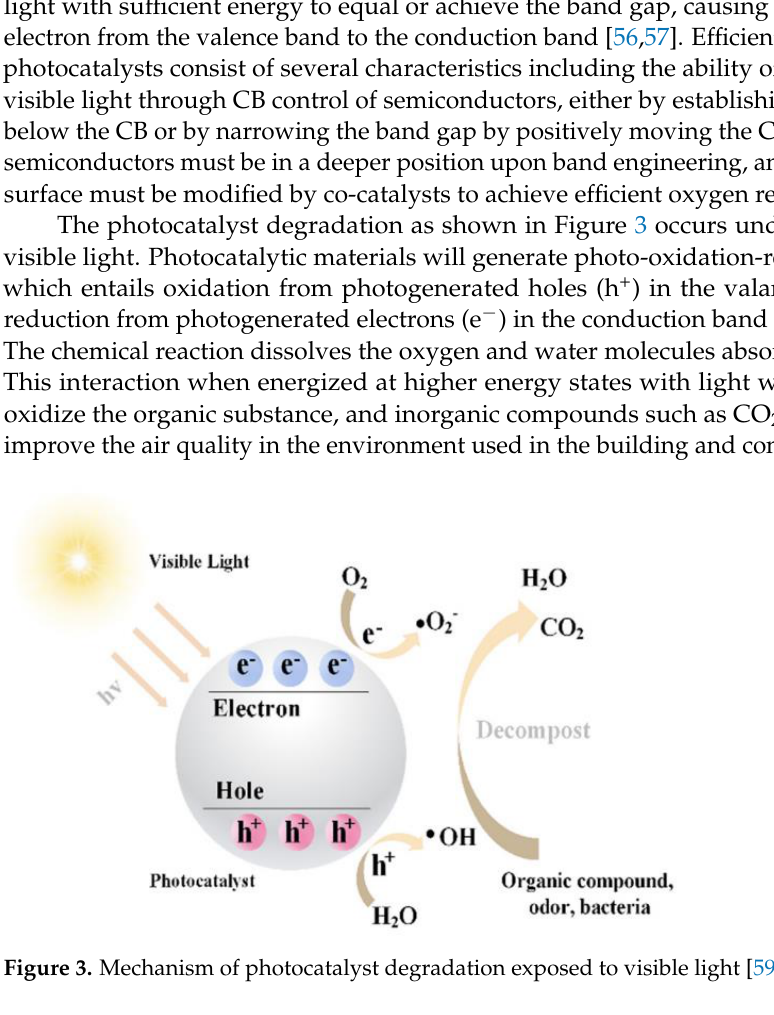
Figure 2. Shifting of electrons from valence to conductance band [14].